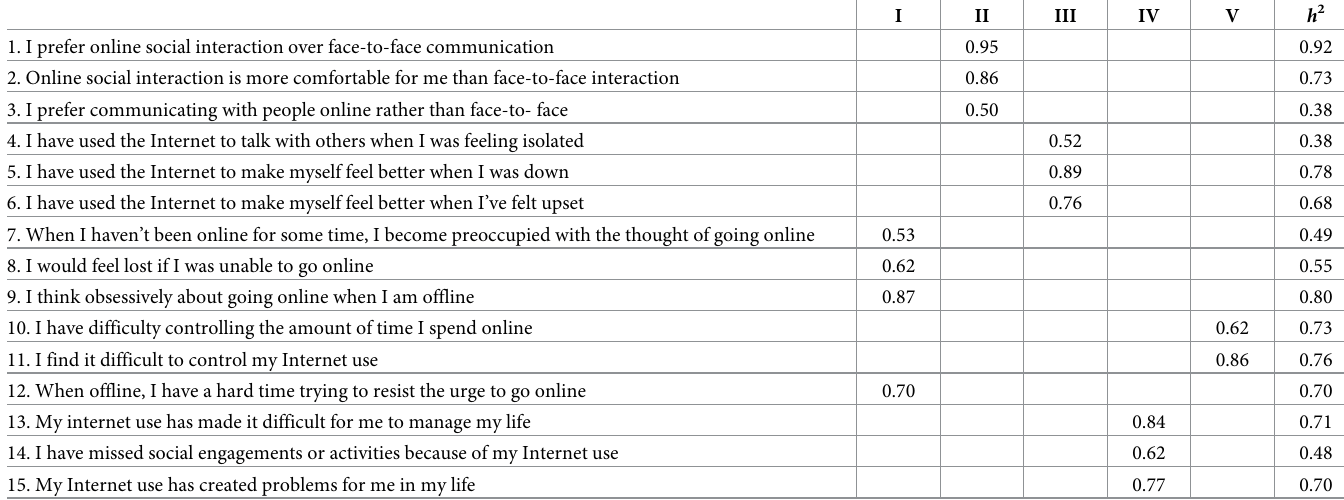
Table 2. Factor loadings of the GPIUS2 items in the final exploratory factor analysis.